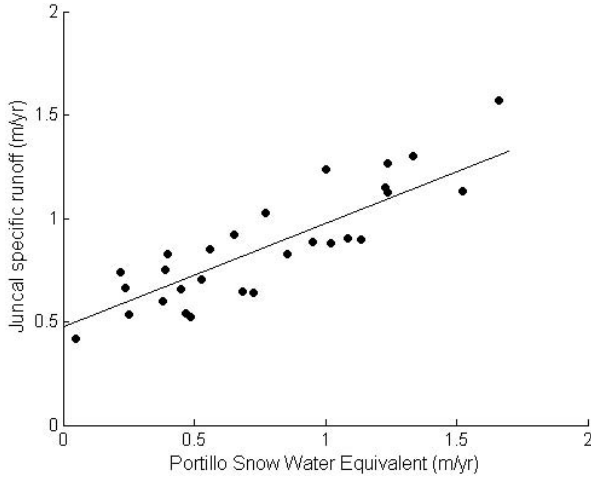
Fig. 4. Juncal River total annual specific runoff (October year x to September year x + 1) plotted against maximum winter Snow Water Equivalent at the Portillo meteorological station in each correspond- ing year ( x ). Data for 28yr between 1970 and 2009 is